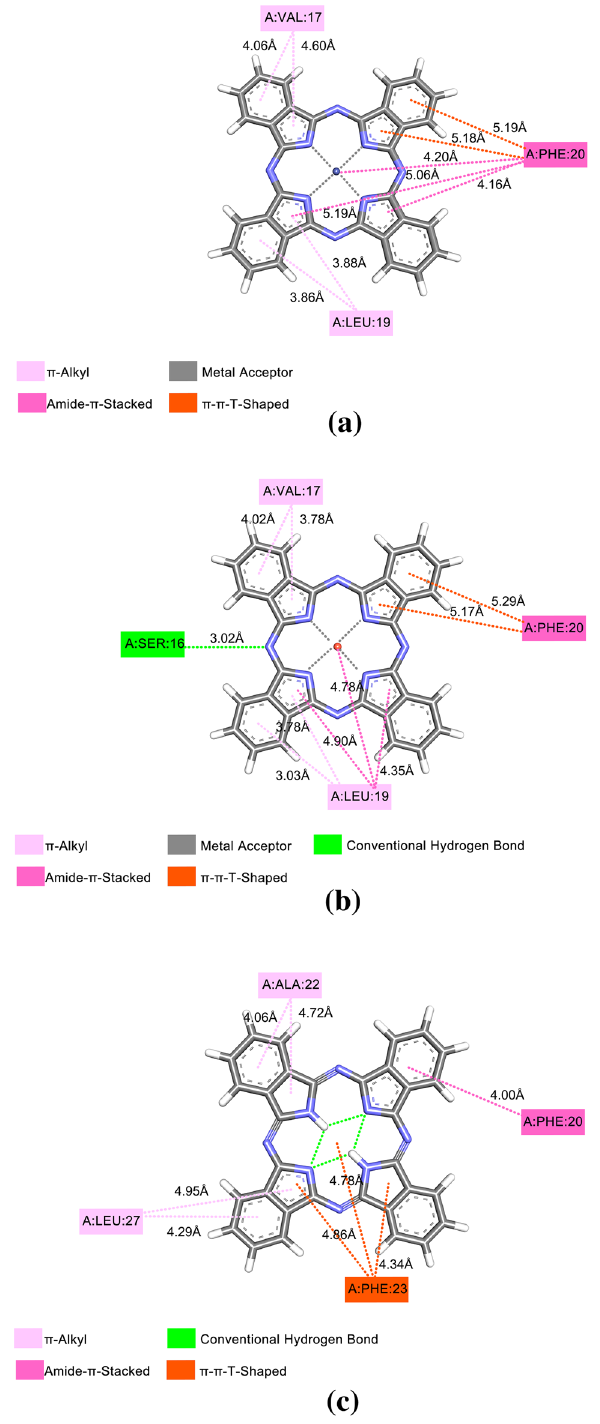
Figure 3. E-pro with: ( a ) CoPc, ( b ) CuPc, e ( c )